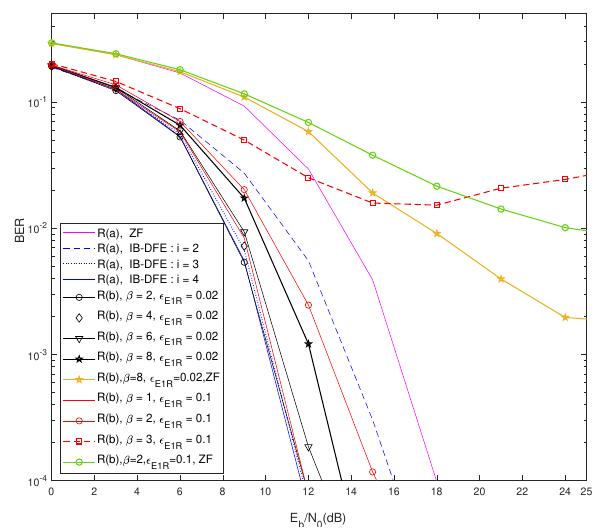
Figure 3. BER performance of R ( a ) and R ( b ) . ZF, zero-forcing.